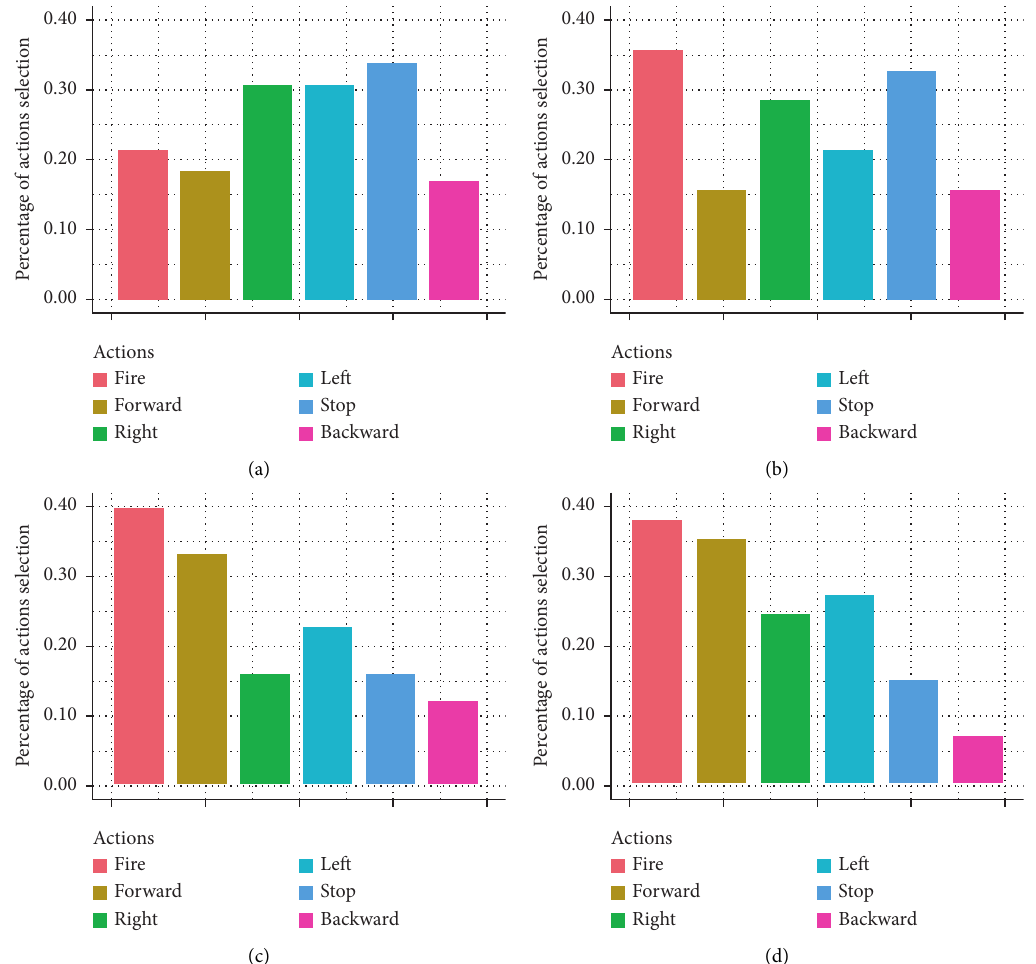
Figure 8: Percentage of actions selected in the 1 st , 2 nd , 3 rd , and 4th quarters of the training phase against “Corners robot.”